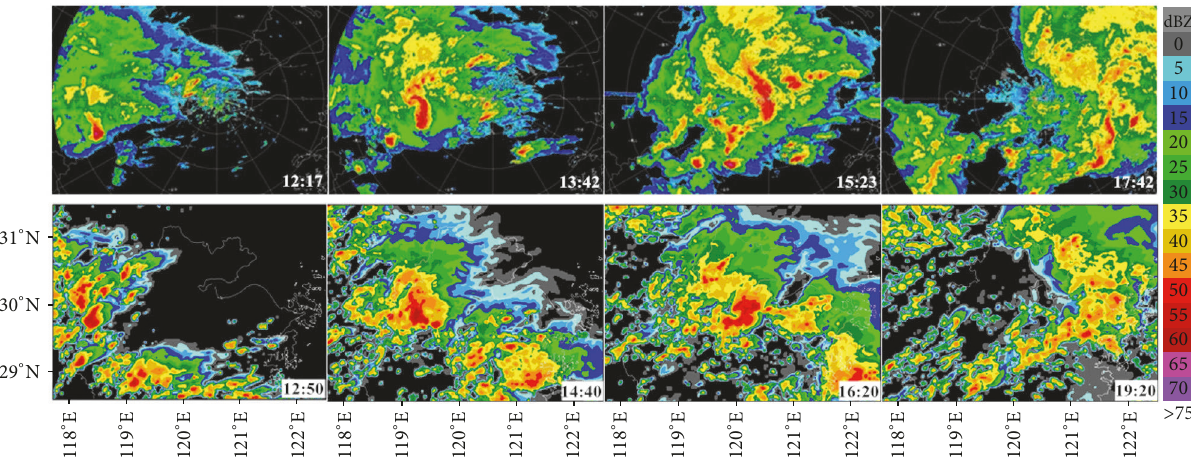
Figure 3: Comparison of the radar reflectivity factor (top) between 12:00 and 18:00 CST on November 9 and the simulated maximum reflectivity (bottom; unit: dBz).